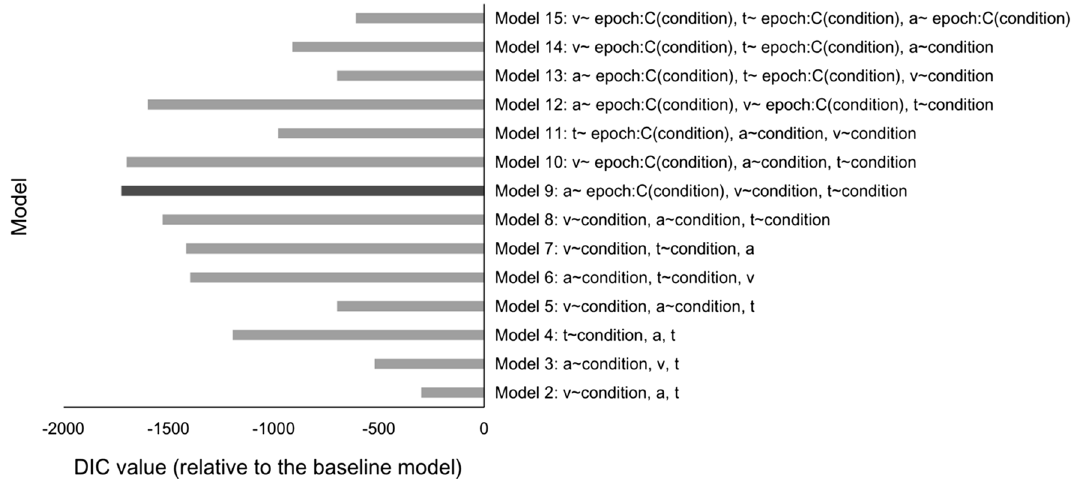
Figure 6. Model comparison. DIC values of several DDM sub-models relative to the baseline DDM model (Model 1, with all parameters fixed; DIC = 7955). v = drift rate; a = boundary separation; t = non-decision time; “ ~ condition” means parameters were dependent on conditions. Here, we have six conditions: 2 configurations (old, new) × 3 trial types (unisensory-visual, multisensory-visual, multisensory-visuotactile). “ ~ epoch:C(condition)” indicates that the parameter is linearly covaried with epoch, while the coefficient β 1 depends on individual conditions. Model 9 (highlighted by the black bar) exhibited the best fit among all models (DIC = 6230), with a DIC difference of more than 10 relative to Model 10 (with the second lowest DIC =